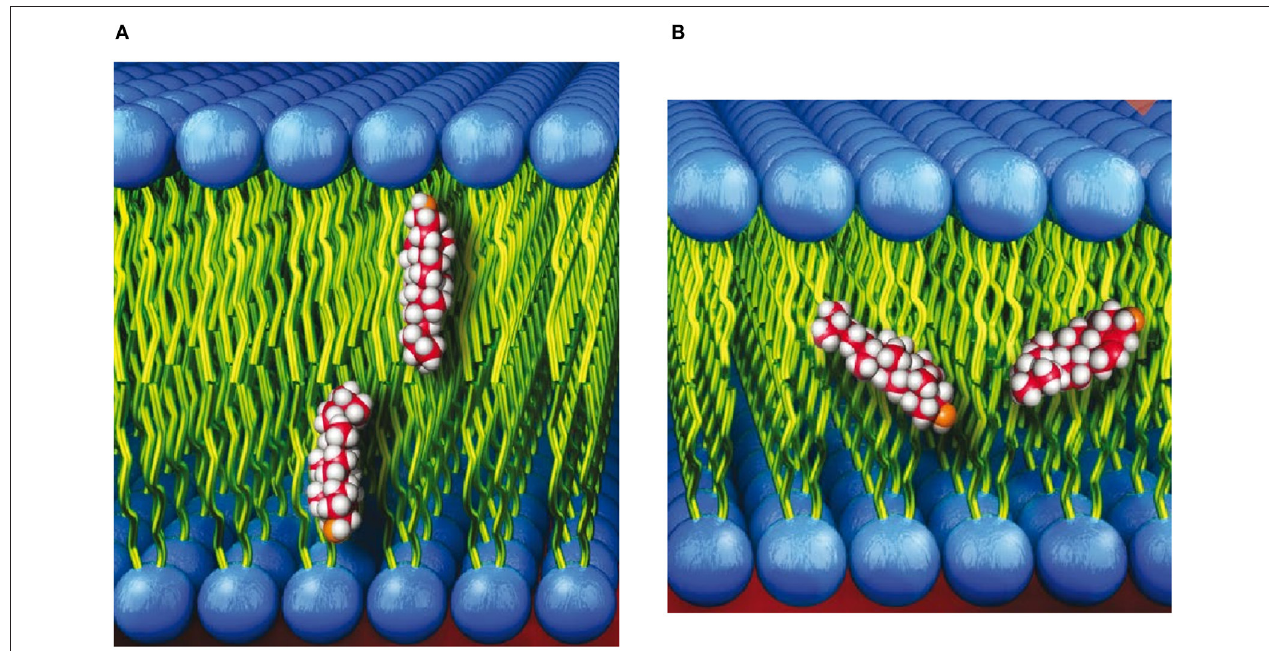
FIGURE 1 | (A) Cholesterol shown in its commonly accepted upright orientation with its hydroxyl group near the lipid-water interface. (B) Cholesterol shown spanning the bilayer leaflets of membranes with “thin” hydrophobic cores.